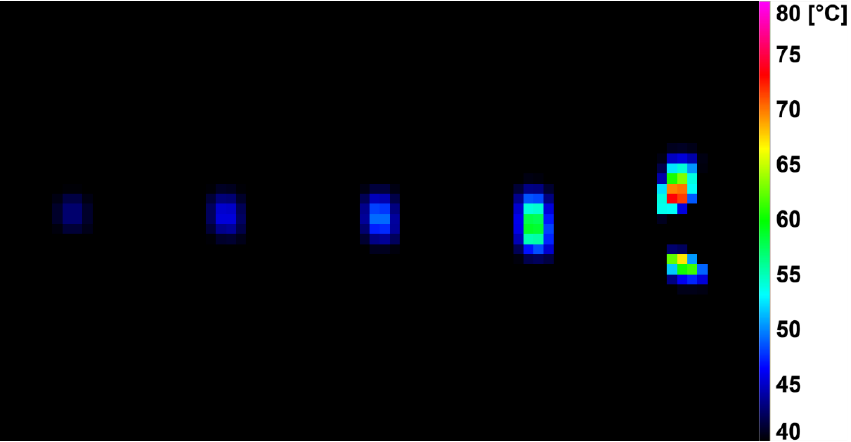
Figure 8. Deformation process of 110 °C_H7 evaluated using IR thermography.